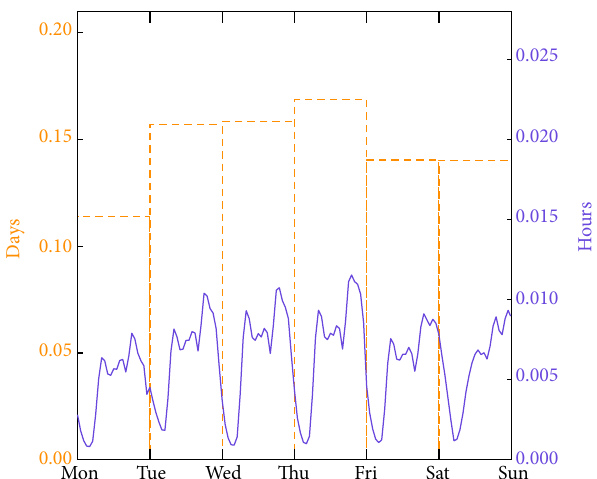
Figure 1: Probability Density Function (PDF) of the number of rides per day of week/hour of day. Afternoon peaks are centered on average around 7